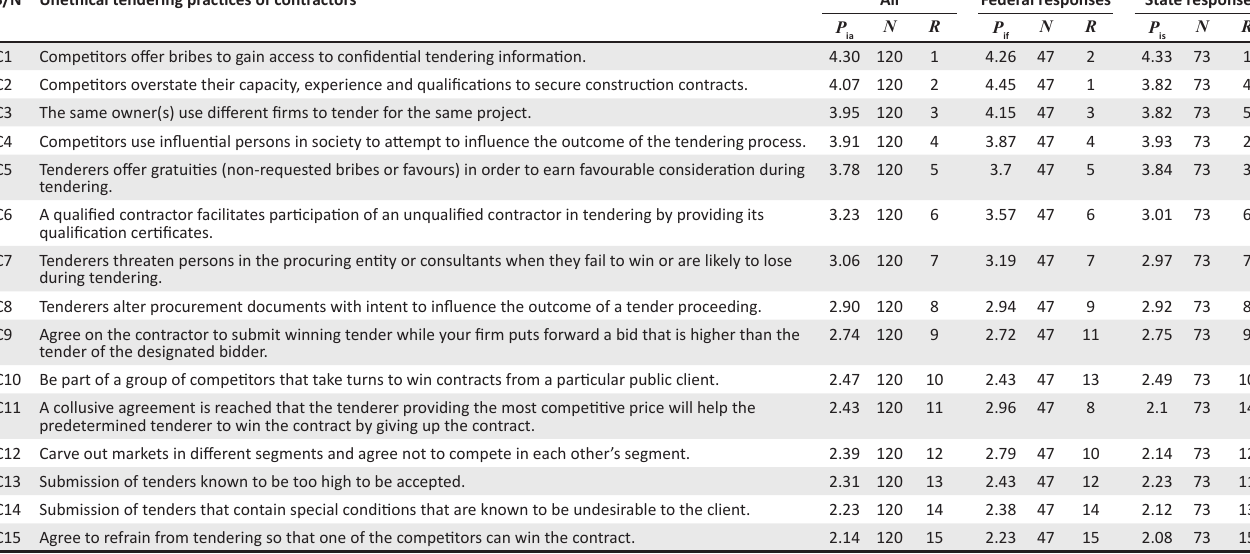
TABLE 3: Responses on unethical tendering practices of